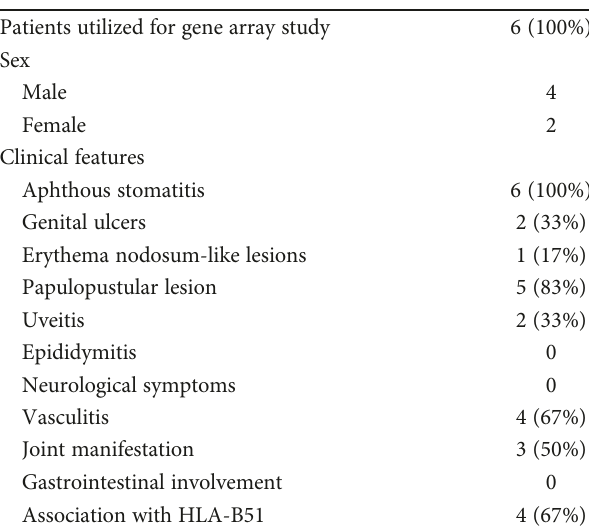
Patients utilized for gene array